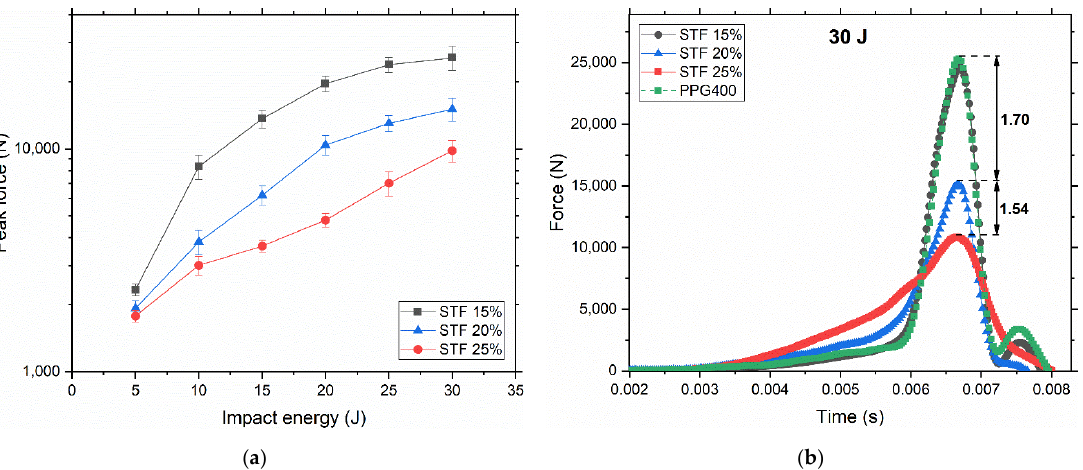
Figure 5. Results from the drop weight test with the hemispherical impactor. ( a ) Peak forces at six different energies with error bars. Percentages represent the weight fraction of fumed silica in STF. Each value is the average of ten tests with an error not exceeding 10%. ( b ) Normal force registered with the load cell as a function of time during 30 J impact. These curves are also the average over ten tests.